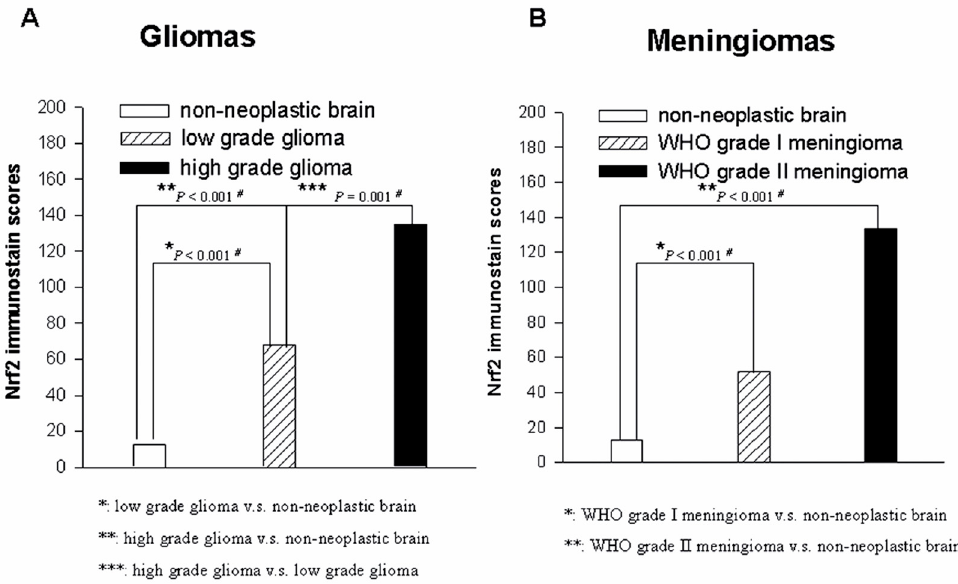
Figure 5. The comparability of Nrf2 imunostain scores in non-neoplastic brain tissue, low grade glioma and high grade glioma ( A ); and the comparability of Nrf2 imunostain scores in in non-neoplastic brain tissue, WHO grade I meningioma and WHO grade II meningioma ( B ).